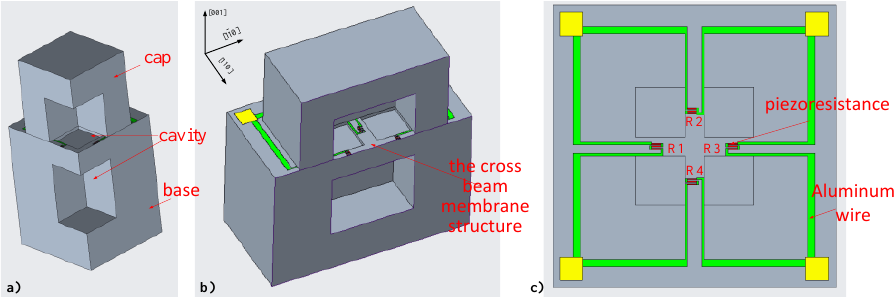
Figure 1. Schematic diagram of the optimized all-silicon pressure sensor structure, ( a ) 1/4 of FEA model, ( b ) 1/2 of FEA model, and ( c ) top view of the device layer.